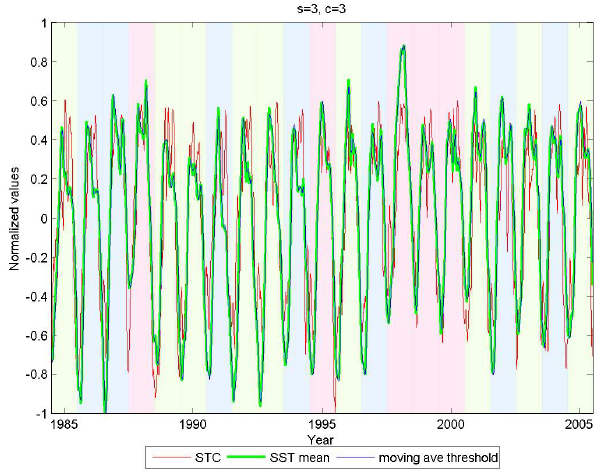
Fig. 7. The STC plots (red) together with the mean of the slice win- dows used in STC calculations (green) and the thresholds obtained by taking the mean of the 5 weeks centered at the current week be- ing analyzed (blue). Each dataset (STC, SST mean and SST moving ave threshold) are mean-centered and divided by their maxima. El Ni˜no years are highlighted in blue, La Ni˜na in red and normal years in